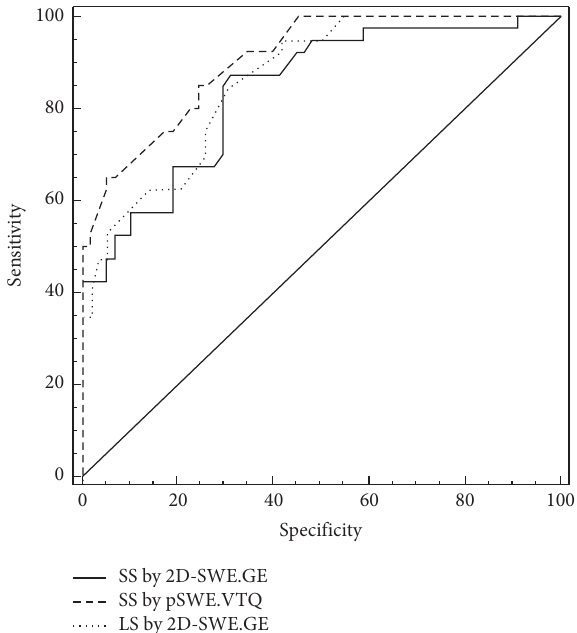
Figure 3: Comparison between receiver operating characteristics for SS (2D-SWE and pSWE) and LS